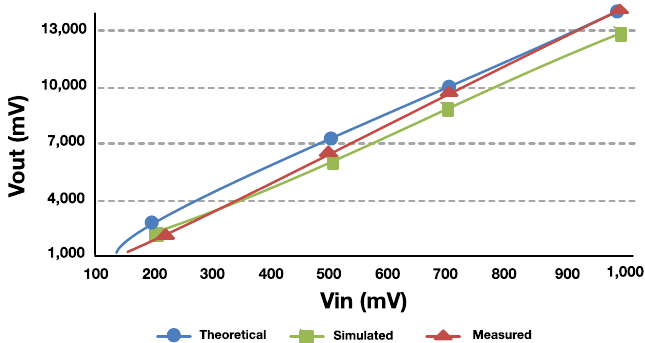
Figure 16. Performance multipliers 4, 5, 6, 7, and 8 stages with a load of 10 k Ω.